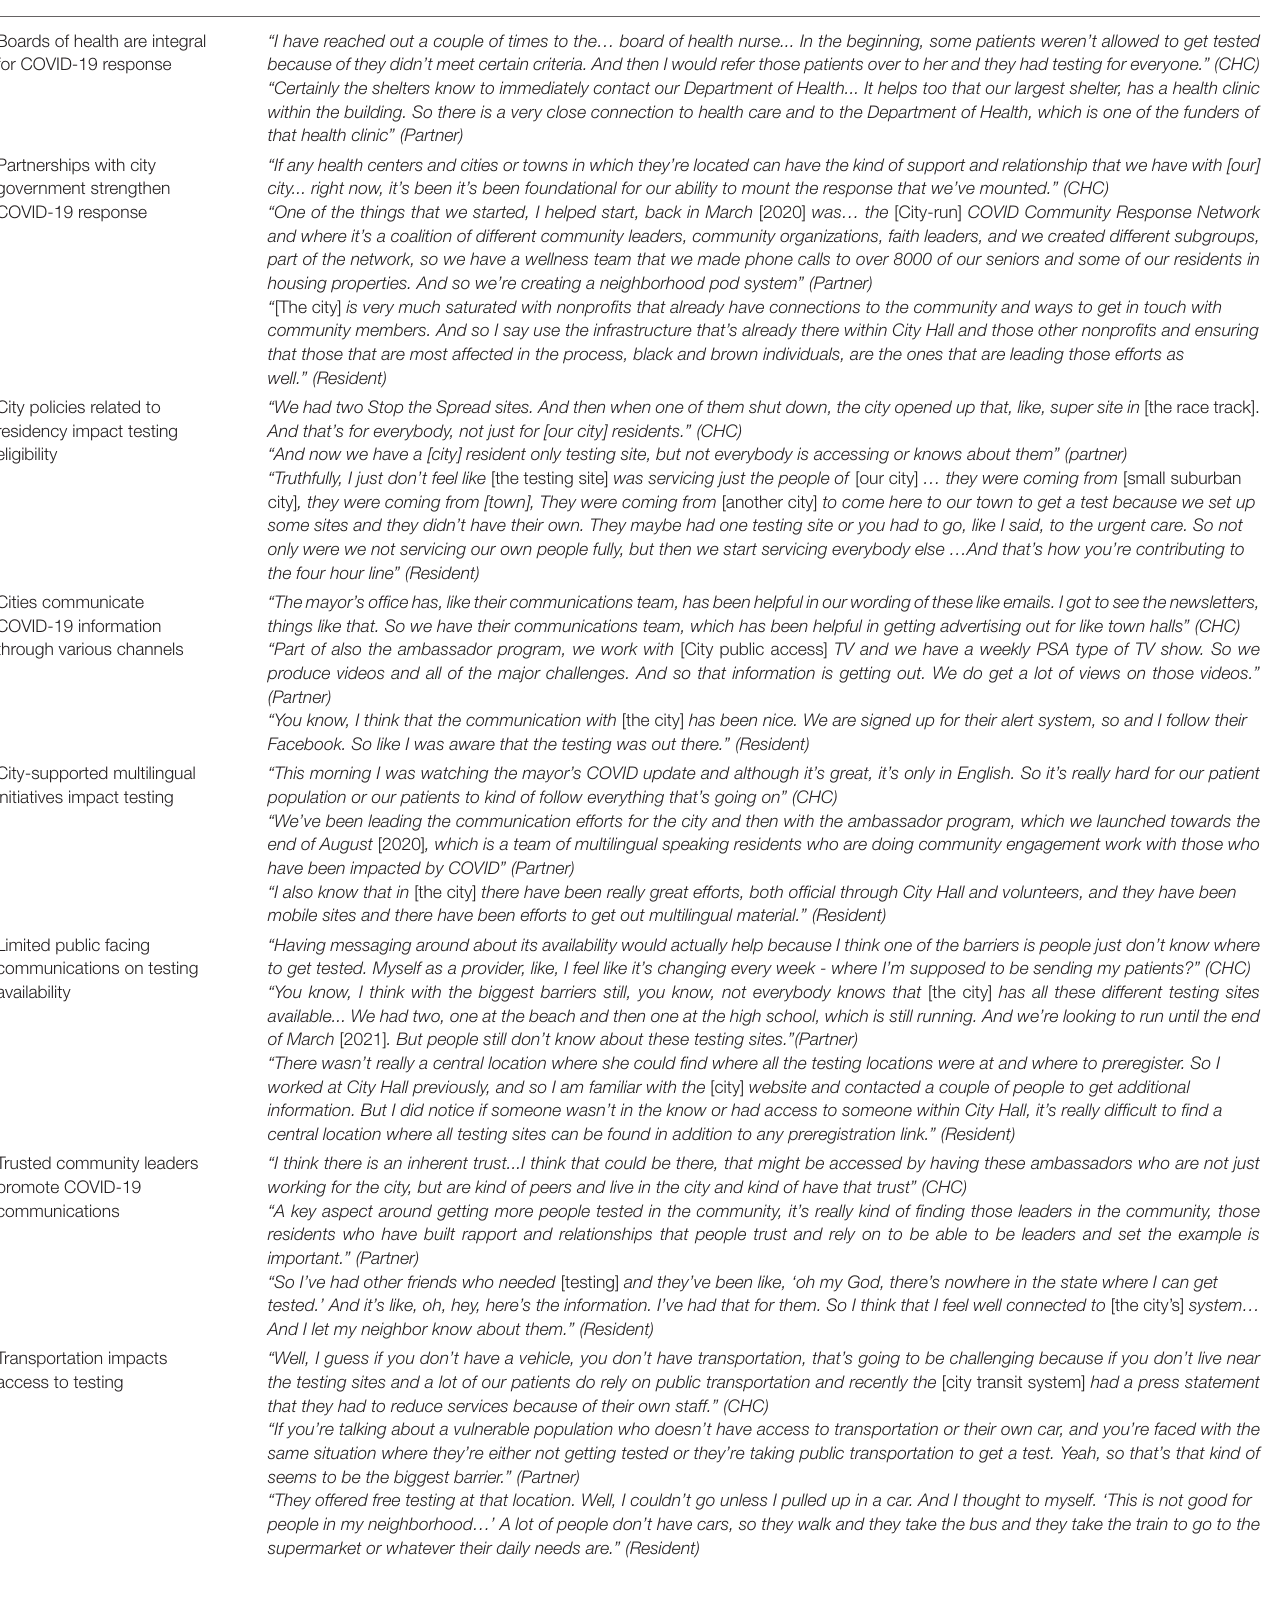
TABLE 2 | Community factors influencing COVID-19 testing reported by community health center staff, partners, and residents. Theme Quotes Boards of health are integral for COVID-19